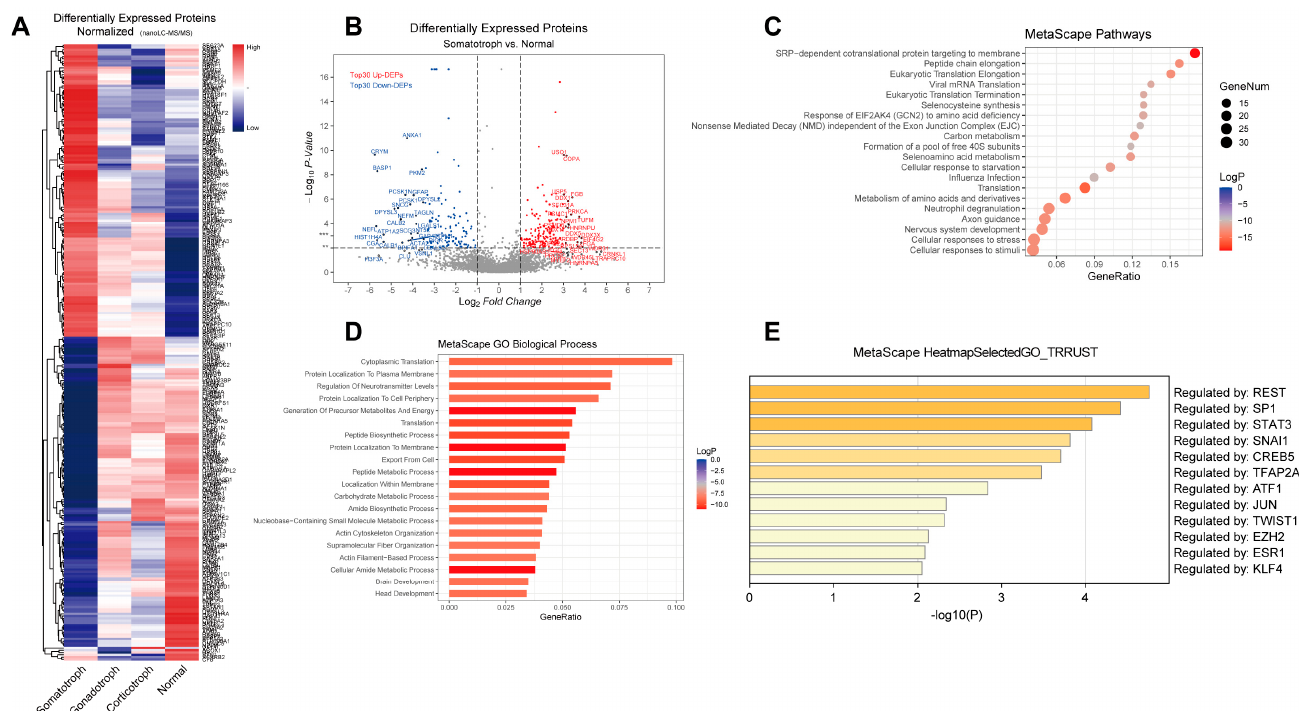
Figure 1. Proteomics analysis of normal pituitary gland and corticotroph adenomas, gonadotroph adenomas, and somatotroph adenomas. ( A ): A heatmap of differentially expressed proteins (FC > 1.5 or FC < 0.67 and FDR q < 0.1). High expression is shown in red; low expression is shown in blue. ( B ): Volcano map of differentially expressed proteins.** p < 0.01, *** p < 0.001 ( C ): KEGG pathway analysis based on differentially expressed proteins. ( D ): The most enriched GO terms. ( E ): Enrichment analysis in TRRUST showing differentially expressed proteins regulated by STAT3, REST, TFAP2A, and SNAI1 based on the Metascape database.